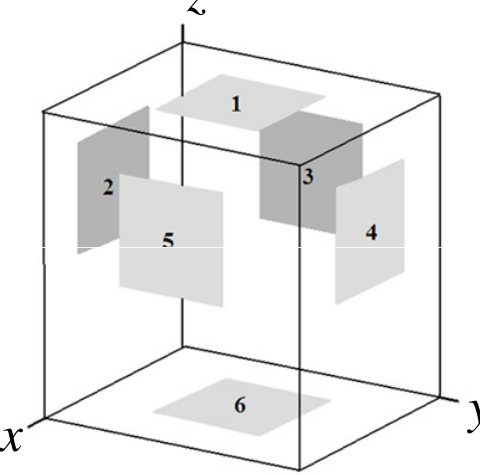
Fig. 1. Scheme of block (size: 81 × 74 × 63cm 3 ) of Topopah Spring tuff sample. Faces of size 30 × 30cm 2 where MSP mea- surements were taken are highlighted in